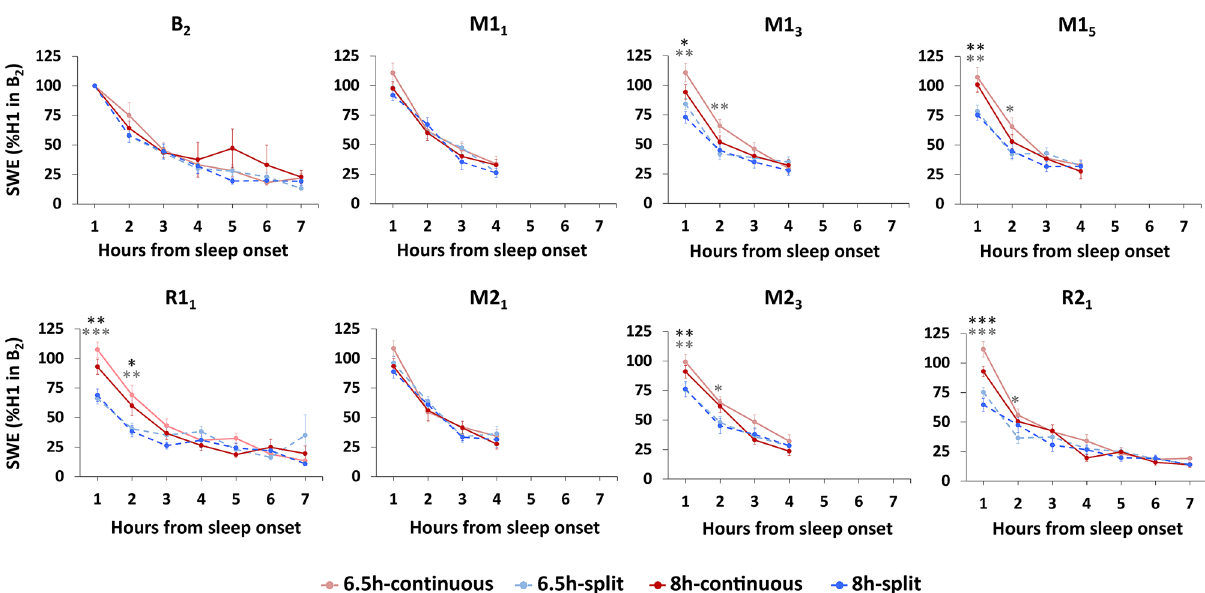
Figure 6. Slow wave energy (SWE) by hour from the onset of N2 sleep (normalized to SWE in the first hour [H1] of the baseline night [B 2 ]). The split sleep schedule was associated with lower SWE in the first hour of nocturnal sleep on manipulation nights that were later in the week (M1 3 , M1 5 and M2 3 ) and recovery nights (R1 1 and R2 1 ). This suggests reduced sleep pressure for both the 6.5-split and 8 h-split groups. On nights that did not have a preceding nap (M1 1 , M2 1 ), there were no significant differences in SWE for the first hour of sleep (ps > 0.214). Across all days and under all sleep schedules, the amount of SWE decreased as sleep progressed and levelled off after approximately 4 h of sleep. This would indicate that sleep pressure experienced by participants after waking in the morning would be similar across groups. Mean ± SEM. ***p < 0.001, **p < 0.01, *p < 0.05 for split and continuous contrasts under 6.5 h (light grey asterisks) and 8 h durations (dark grey the same sleep opportunity during the consolidation periods after learning. For the picture encoding task in particular, this means that any group differences can most likely be attributed to the effects of splitting sleep on the single encoding session that occurred at the end of the first week. What neural mechanisms could account for this nap benefit? The synaptic homeostasis hypothesis (SHY) posits that slow-wave activity during sleep globally downscales the synaptic weights that are potentiated during encoding across the day, and this avoids saturation in memory networks 40 . It follows that encoding capacity